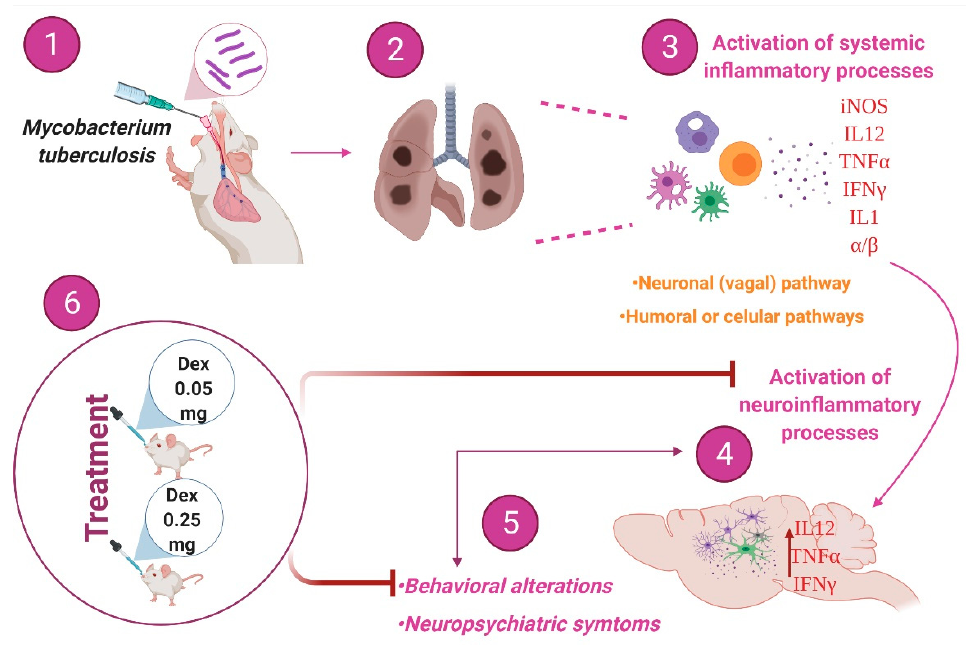
Figure 12. Intranasal administration of DEX decreases neuroinflammation and behavioral and neuropsychiatric symptoms in a murine model of pulmonary TB without aggravating lung disease. ( 1 ) The pulmonary infection with M. tb in a murine model ( 2 ) promotes the development of active disease in animals. ( 3 ) Intense inflammation due to the immune response against mycobacteria in the lungs induces neuroinflammation by humoral and neuronal pathways, ( 4 ) manifested by high production of different cytokines ( 5 ), induces behavioral alterations and neuropsychiatric symptoms such as depression and anxiety. ( 6 ) The intranasal administration of DEX reduces the production of cytokines due to the anti-inflammatory effect of this GC, and allows the use of low doses, being beneficial to the infected animals (Created with BioRender.com, accessed on 20 May 2021).